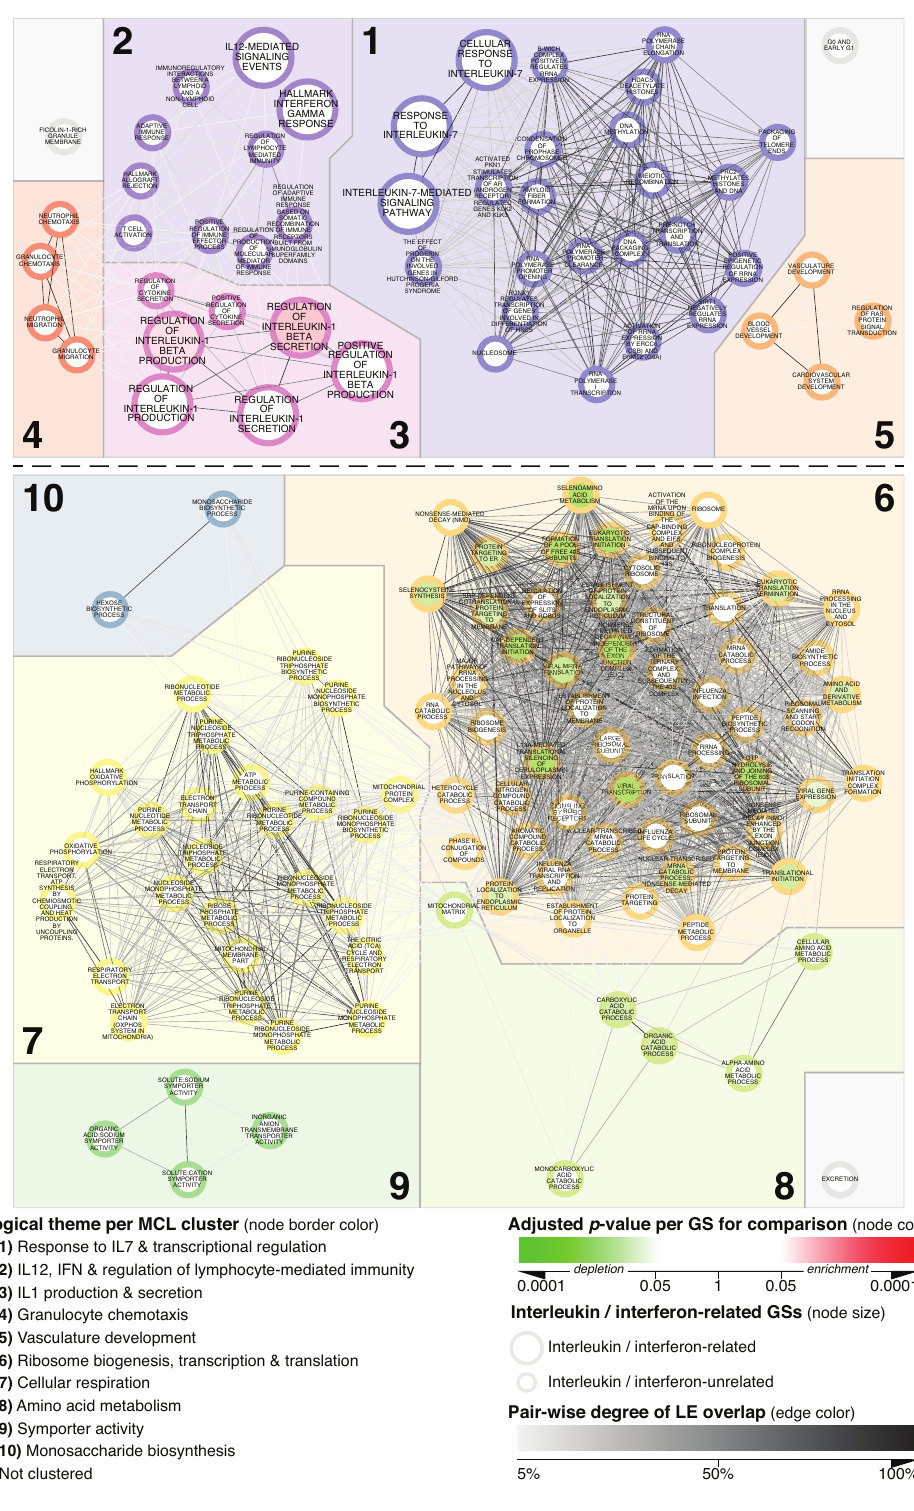
Figure 3. MCD’s glomerular transcriptional landscape delineating contextualized alterations in gene expression between MN and N_CTRL. Any GS passing the significance thresholds of adjusted p < 0.001 and with at least 33.34% of its member genes comprised in its leading edge (LE) when comparing MCD vs. N_CTRL was mapped as a node within the basic network. Onto this scaffold, the parameters listed in the legend for the comparison of MN vs. N_CTRL were mapped. By keeping all mapping parameters constant, this figure is directly comparable with Figures 1 and